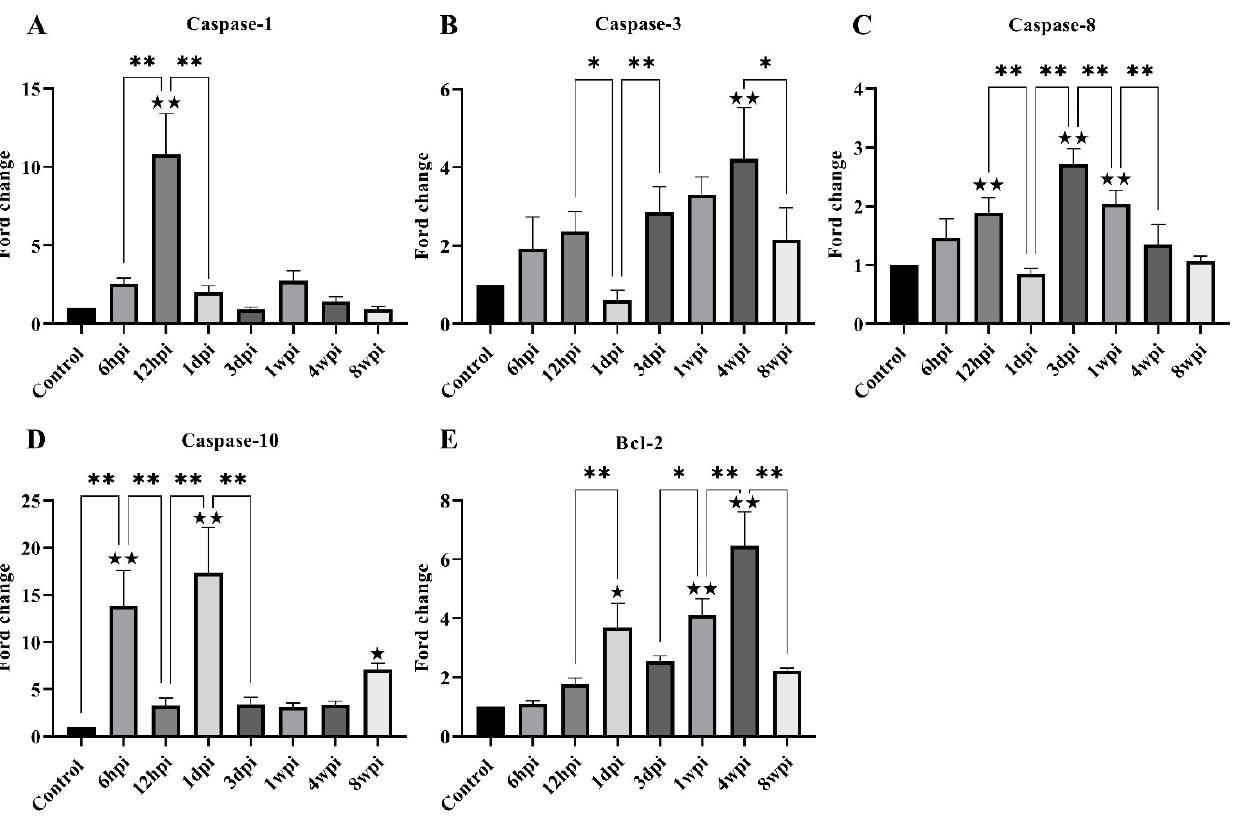
Figure 6. The level of mRNA expression of genes related to skin apoptosis. (A): Caspase-1, (B): Caspase-3, (C): Caspase-8, (D): Caspase-10, (E): Bcl-2. Data are represented as the mean ± standard deviation (M ± SD). A one-way ANOVA analysis was used to analyze the variances between the groups. The horizontal line indicates a significant adjacent pairwise group difference (* p < 0.05 and ** p < 0.01). ★ on the bar represents a significant difference between the specific experimental group and the control group ( ★ p < 0.05 and ★★ p < 0.01).